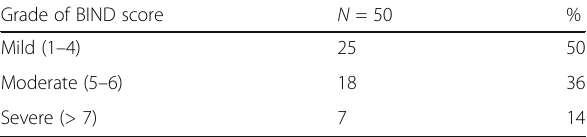
Table 7 The grade of BIND score in group